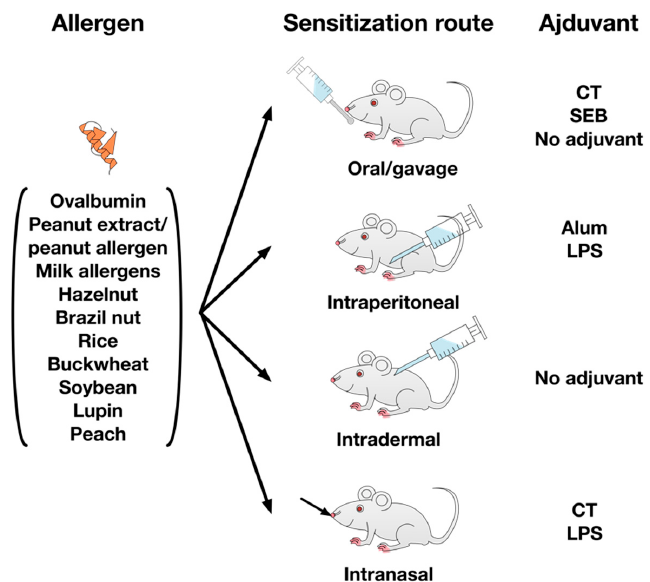
Figure 4. Allergens and adjuvant strategies described in the literature to establish food allergy models. The published mouse food allergy models employ a variety of di ff erent food allergens with hen’s egg, milk, and nut allergens making up the majority of the used allergen sources. To achieve allergic sensitization, the di ff erent allergens are either applied orally with cholera toxin (CT), Staphylococcus enterotoxin B (SEB), or adjuvant-free, intraperitoneally with aluminum hydroxide (Alum) or lipopolysaccharide (LPS), intradermally without adjuvant, or intranasally together with CT and LPS.